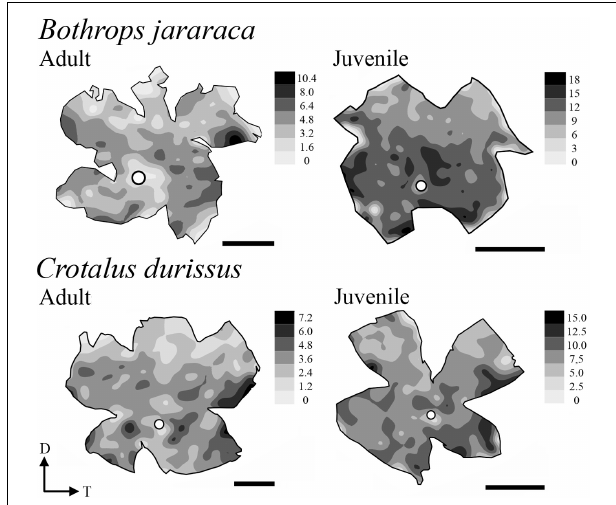
FIGURE 10 | Representative retinal topographic maps of the GCL cells of adults and juveniles of B. jararaca and C. durissus . Gray bars indicate the density of cells per mm 2 , and the values should be multiplied by 10 3 . The optic nerve head is depicted as a white circle. D, dorsal; T, temporal. Scale bars 2